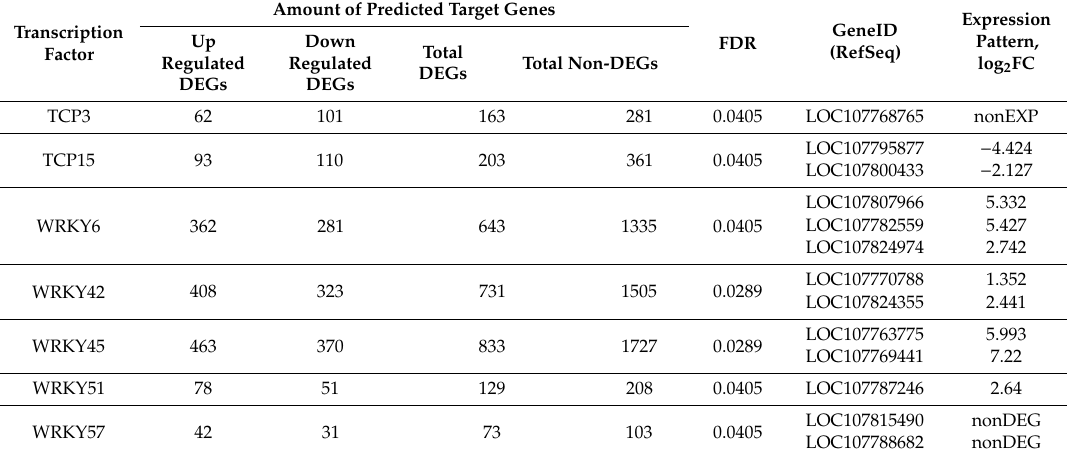
Table 1. Transcription factors for which the pools of target genes were enriched with genes expressed di ff erentially in non-infected and P. atrosepticum -infected tobacco plants. FDR values were obtained using Fisher’s exact test with BH adjustment. The “expression pattern” column shows log 2 FC values for the expression of genes encoding the TFs. Non-EXP stands for non-expressed gene; non-DEG stands for non-di ff erentially expressed